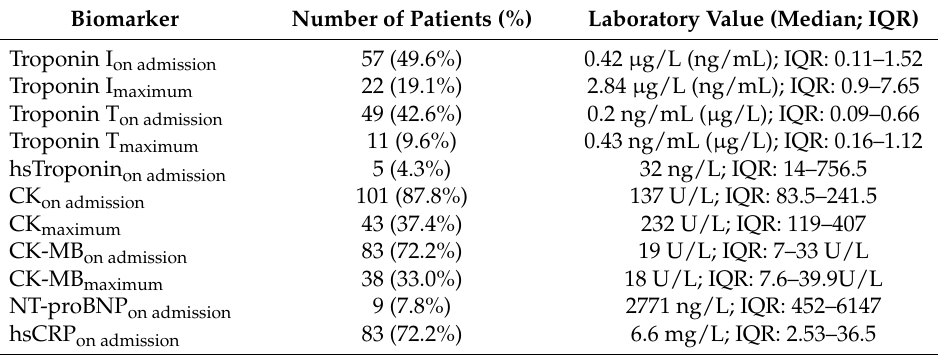
Table 3. Admission and peak biomarkers of our TTC patients (total number, n = 115;